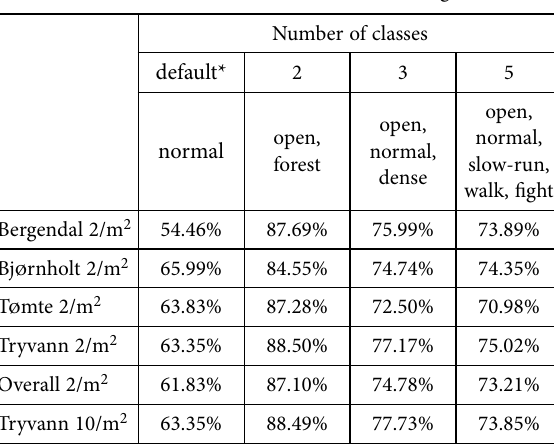
Table 8. Classification rates for different number of classes. For 5 classes, all five classes in Table 7. Classification rates. are used. For 3 classes, ‘slow-run’, ‘walk’ and ‘fight’ are merged to ‘dense’. For 2 classes, ‘normal’ and ‘dense’ are merged to